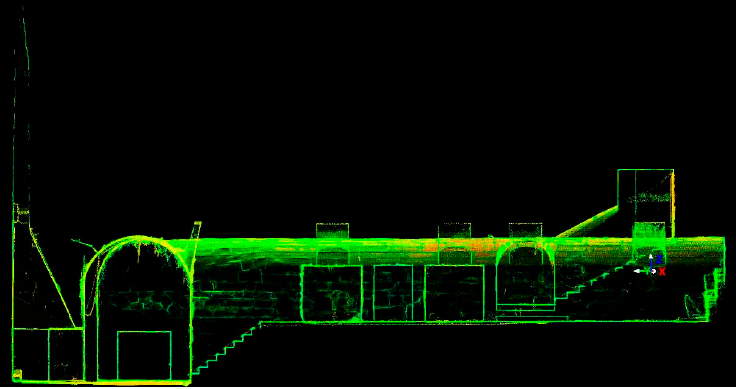
Figure 10. High density point clouds generated from Leica P40 scans. The scanned area corresponds to the upper and lower vaulted cellars of the Galería de Convalecientes . On the left side a smokestack can be seen. The stone staircase that leads to the level of the Jardín de los Frailes is shown on the right side.